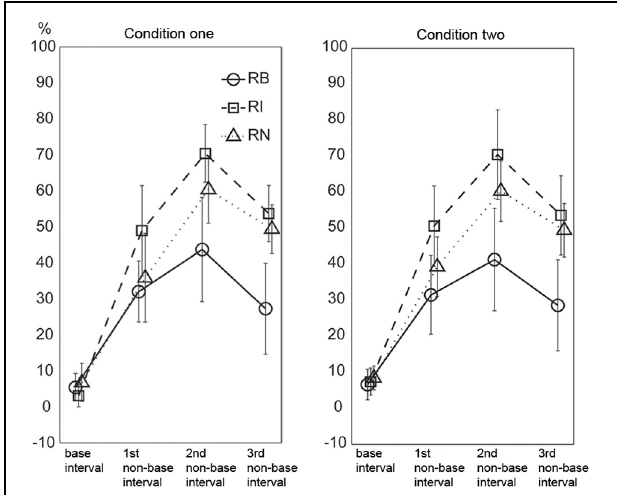
FIGURE 9 | Percentage of incorrectly reproduced intervals. For non-base intervals, the reproduced error rate was lower for the 1:2:4:8 rhythm type than for the 1:3:5:6 and 1:2.3:5.3:6.4 rhythm types. Error bars indicate ± 95% confidence intervals. RB, RI, and RN represent rhythms formed with b inary, non-binary i nteger, and n on-integer ratios,